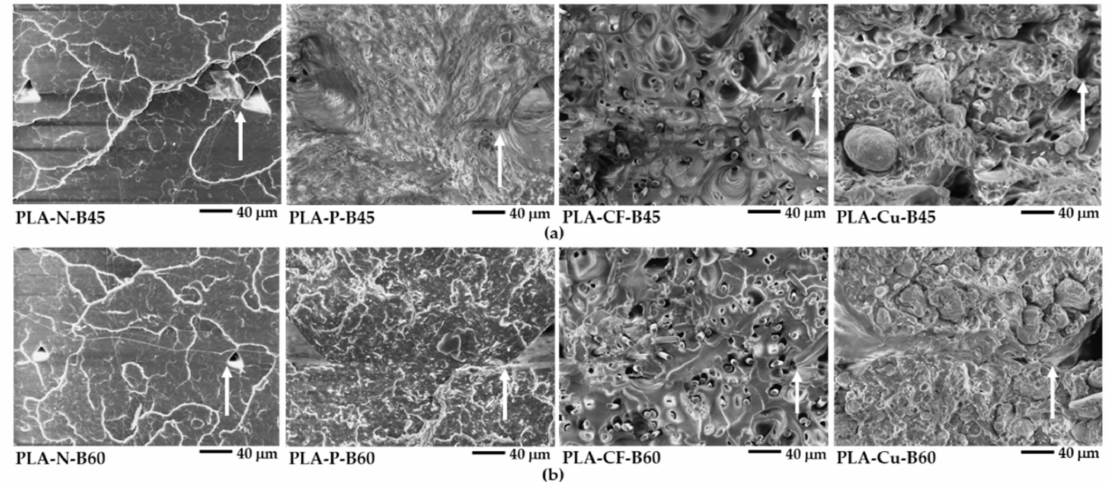
Figure 14. SEM images of tensile fractured surfaces of 3D printed samples at high magnification ( × 500): ( a ) at bed 45 ◦ C and ( b ) at bed 60 ◦ C.